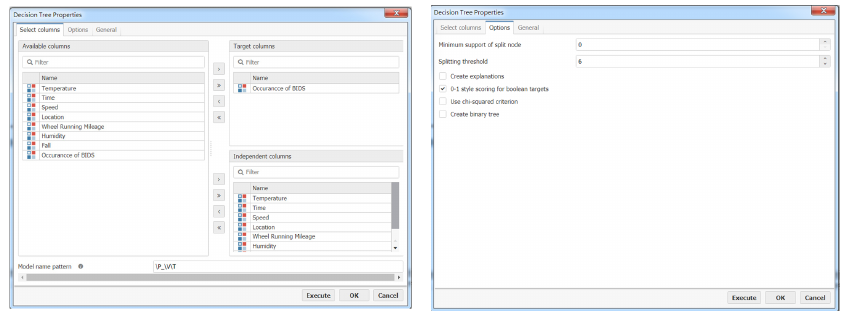
Table 11. Partial sample set of original data.